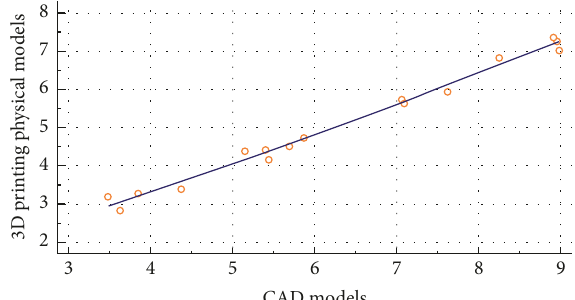
Figure 10: Correlation of the diameter of the stenosis segment measured in the 16 3D printing models and CAD models.